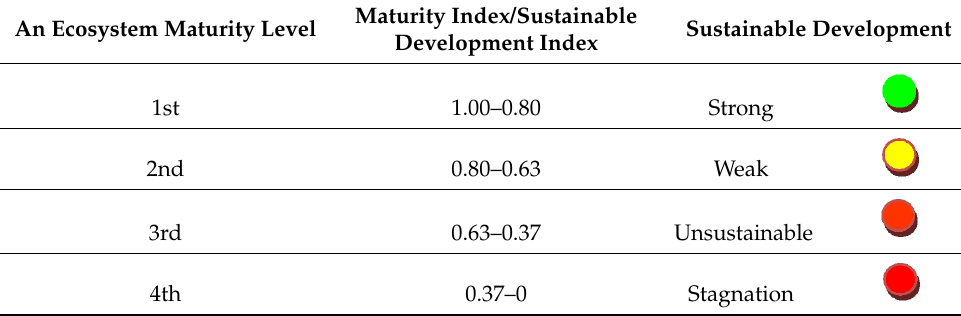
Table 3. Scale of maturity of the regional entrepreneurial ecosystem.